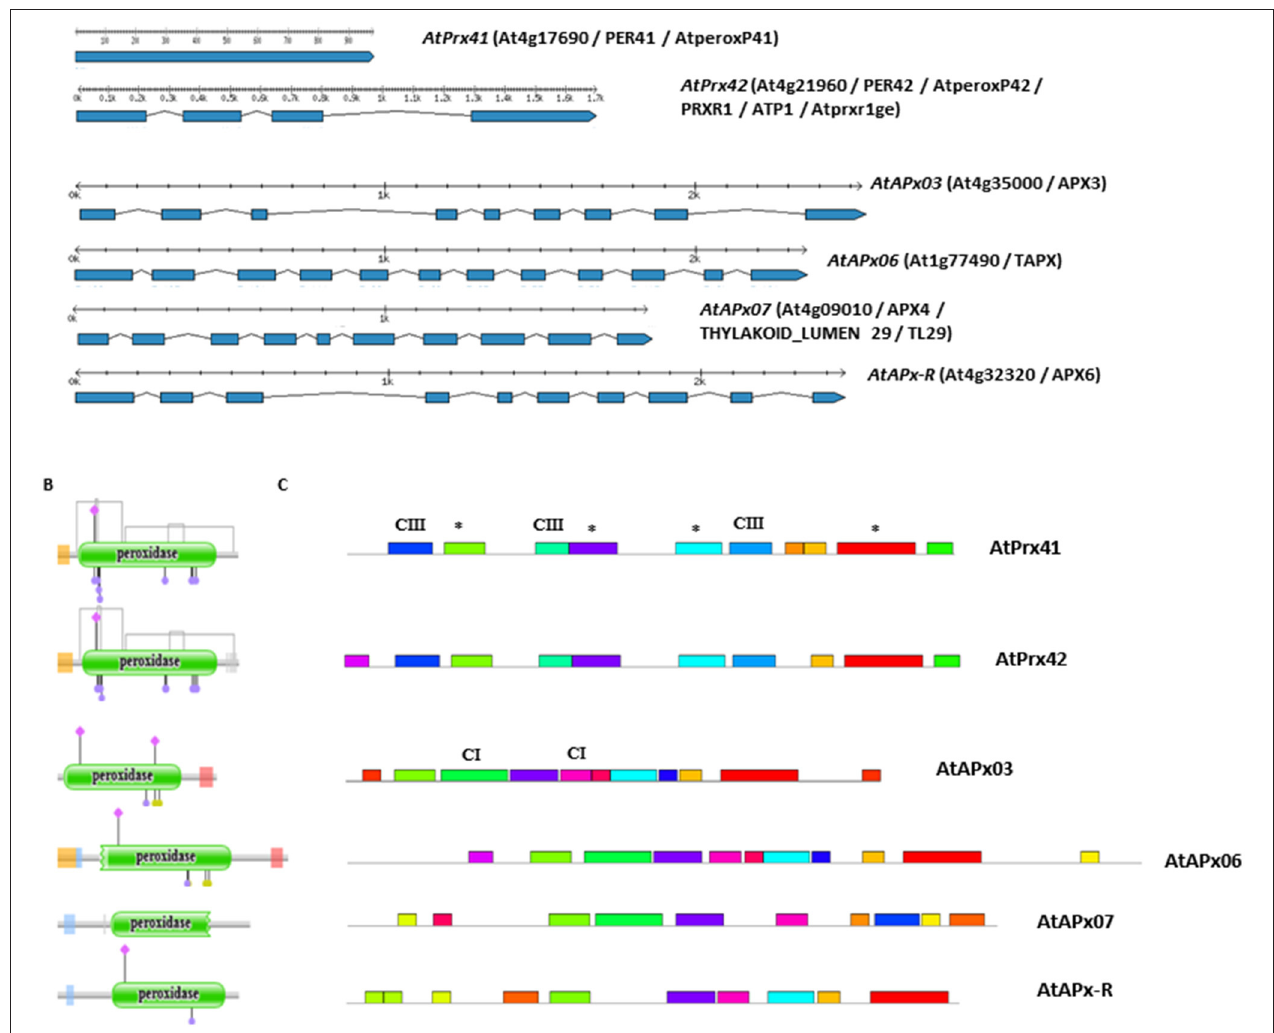
FIGURE 2 | Two CIII Prxs (AtPrx41 and AtPrx42) and 4 APxs (AtAPx03, AtAPx06, AtAPx07, and AtAPx-R) sequences from A. thaliana have been compared using various available tools. (A) Structure intron/exon. Exons (blue boxes) and introns (gray lines) are drawn in scale. (B) Location of the unique PFAM domain PF00141 (green boxes), di-sulfide bridges (gray links) and conserved amino acid residues (pink diamonds, purple, and other disks) (Blázquez et al., 2003). (C) Conserved motifs in CIII Prxs and APxs. The MEME program was used to identify conserved motifs. The maximum number of motifs was set to 10, the optimum width of motifs to 15–50 amino acid residues (Brown et al., 2013). Each colored box represents a different motif found in CIII Prxs and/or APxs. CIII: motifs only found in CIII Prx protein sequences; CI: motifs only found in CI Prx protein sequences; *: motifs in common between CIII and CI Prx protein sequences. All the sequences are available from the Redoxibase (Savelli et al.,